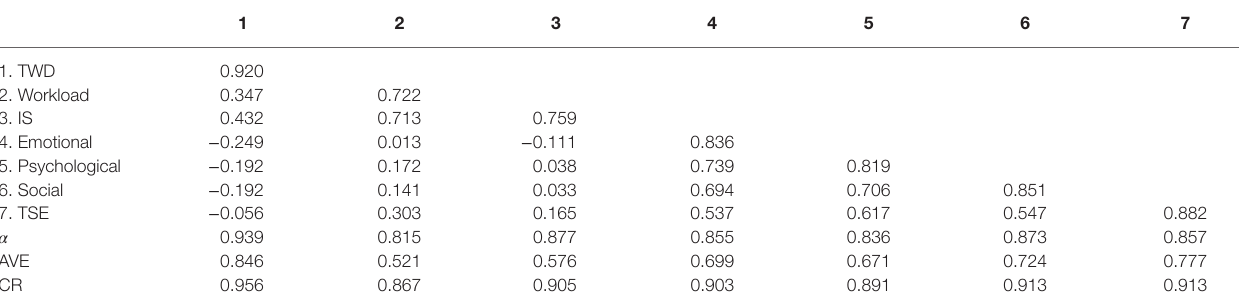
TABLE 2 | Measurement.